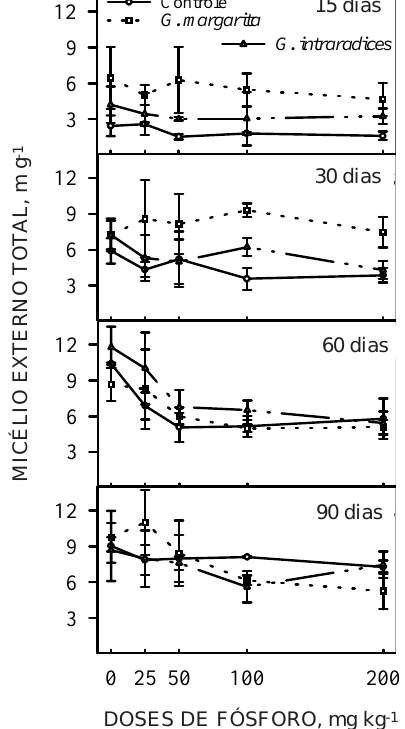
DOSES DE FÓSFORO, mg kg Figura 3. Estimativa do comprimento de micélio externo total em substrato cultivado com soja inoculada com fungos micorrízicos arbusculares ( G. margarita ou G. intraradices ) ou não inoculada (Controle), aos 15, 30, 60 e 90 dias do transplantio, considerando as doses de P. Barras verticais representam o desvio-padrão de três repetições, quando maiores que os símbolos.